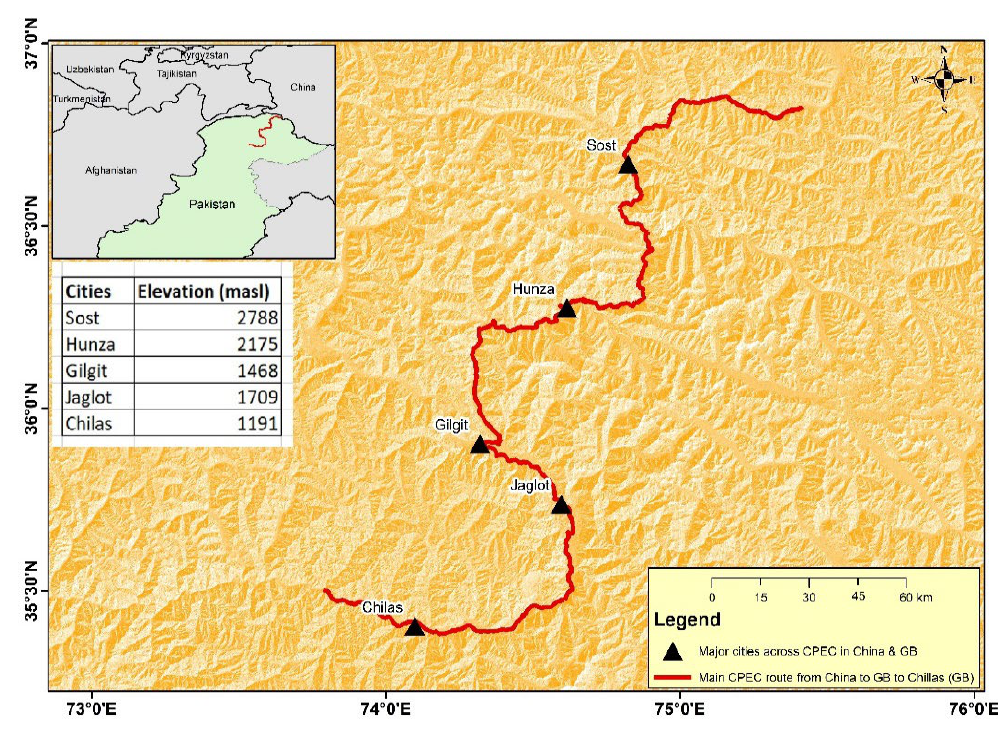
Figure 1. A detailed map of the study area showing Sost, Hunza, Gilgit, Jaglot and Chilas.